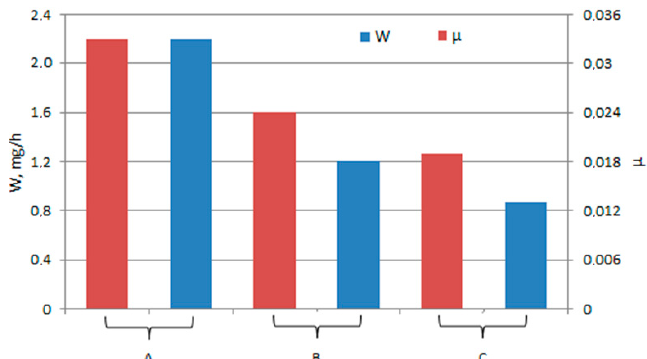
Figure 7. Wear rate of chrome-plated coatings in the friction pair with stuffing box seal and the value of the coefficient of friction: A—steel 40KHN; B—chrome coating (quiet electrolyte); C—chrome coating (flowing electrolyte).